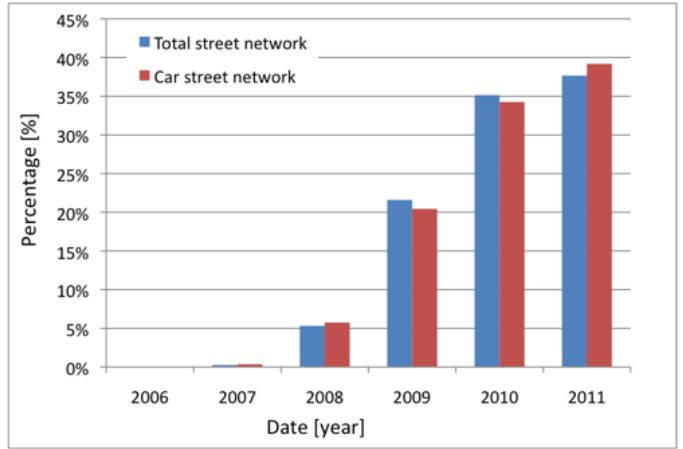
Figure 16. Actuality of the OSM Route